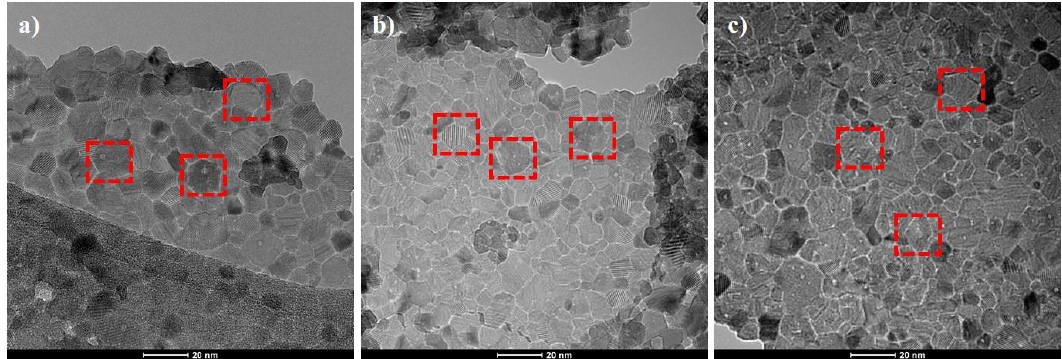
Figure 2. Transmission electron microscopy (TEM) images of ( a ) unmodified CeO 2 nanoparticles and ( b , c ) the modified CeO 2 /DDA and CeO 2 /NMTU, respectively. Table 1. Elemental Analysis of unloaded and loaded CeO 2 nanoparticles. Samples